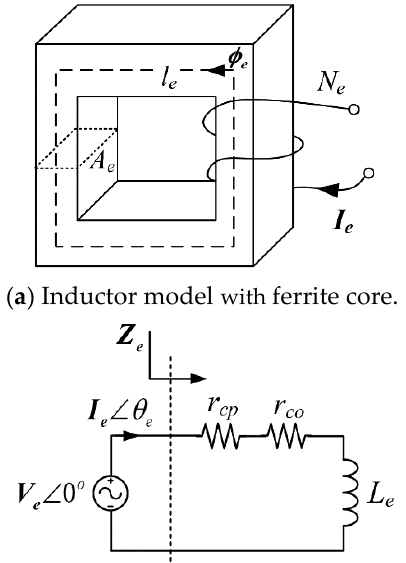
Figure 1. Circuit configuration of the inductor model and test circuit for complex permeability.